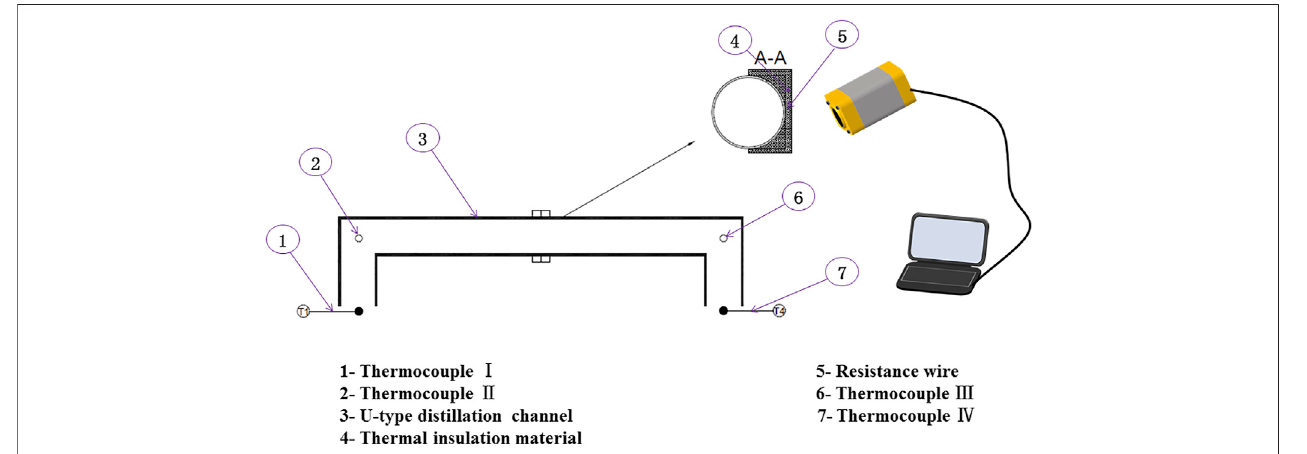
FIGURE 1 | Schematic of the experimental apparatus.